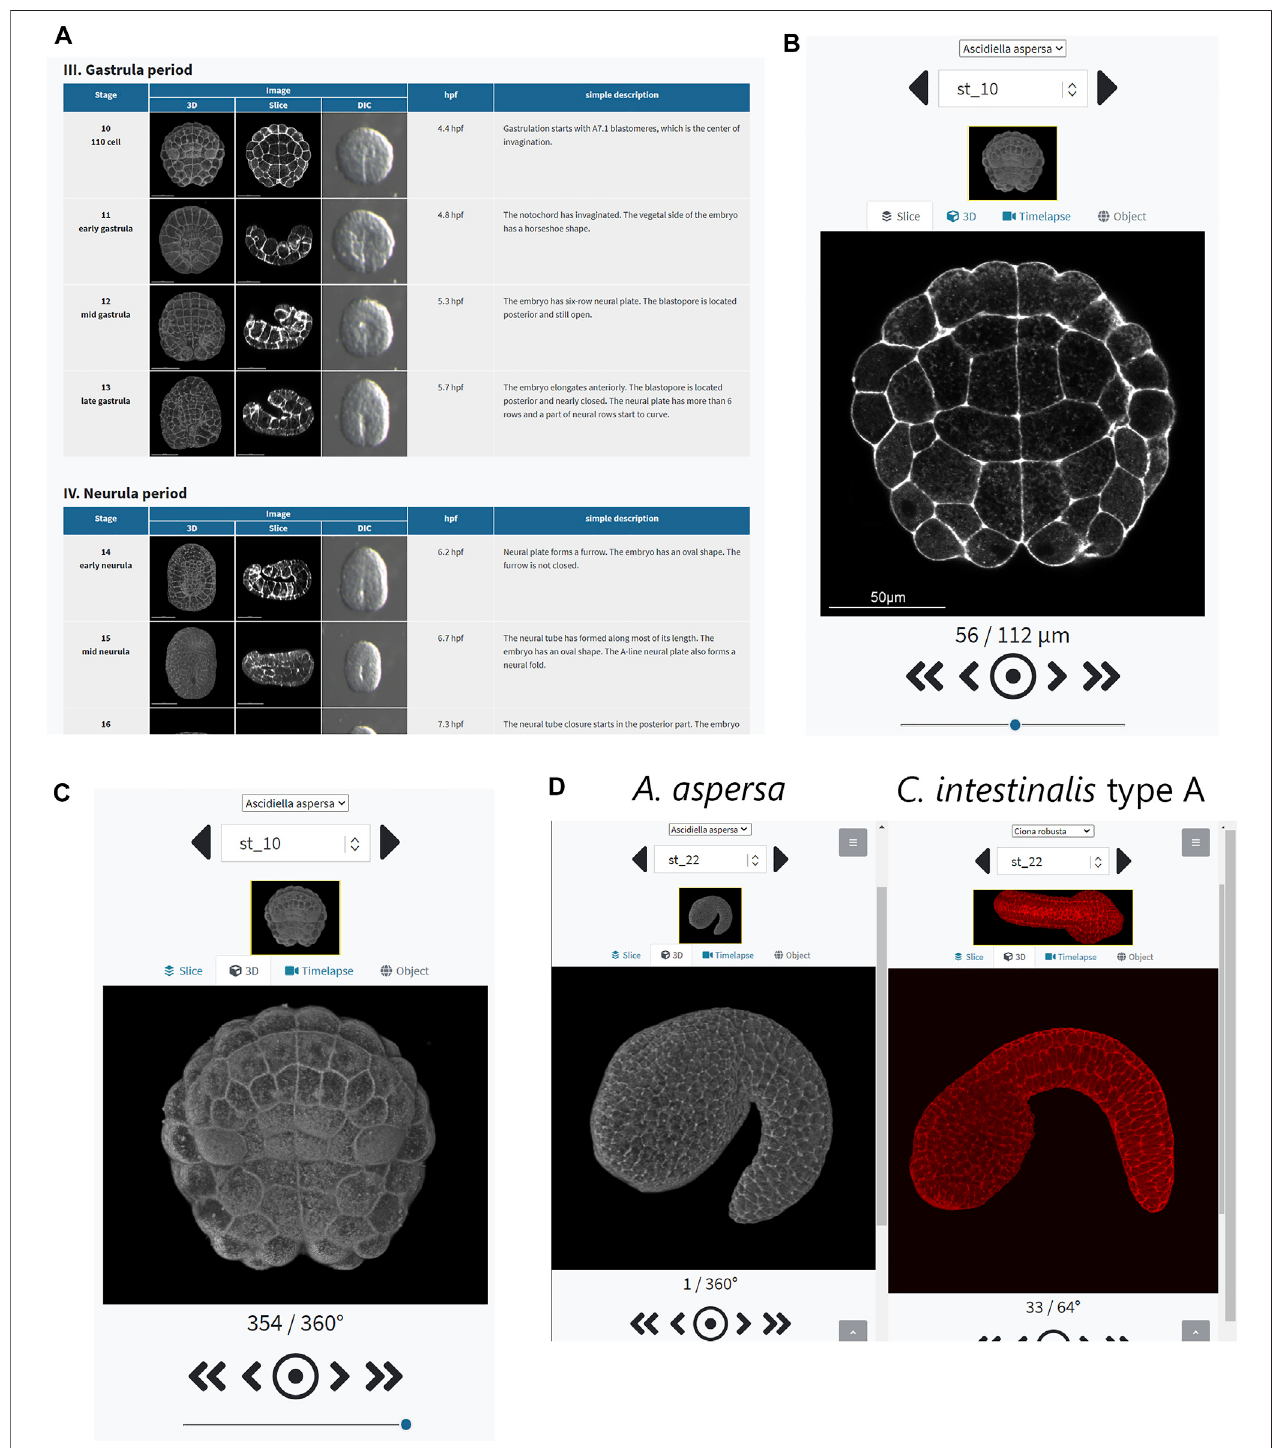
FIGURE 9 | Screenshot of the database. To use the database, please refer to the website: https://www.bpni.bio.keio.ac.jp/RAMNe/latest/index.html. (A) “ Developmental table ” refers to the two-dimensional images from a fertilized egg to the hatched larva as viewed by CLSM and Nomarski. (B) Information about section images. (C) Informationabout3Dimages. (D) “ Dualdisplaymode ” candisplayandcomparetheimagesof A . aspersa andcomparedto C . intestinalis typeA(Hottaetal., 2007; Hotta et al., 2020) interactively.